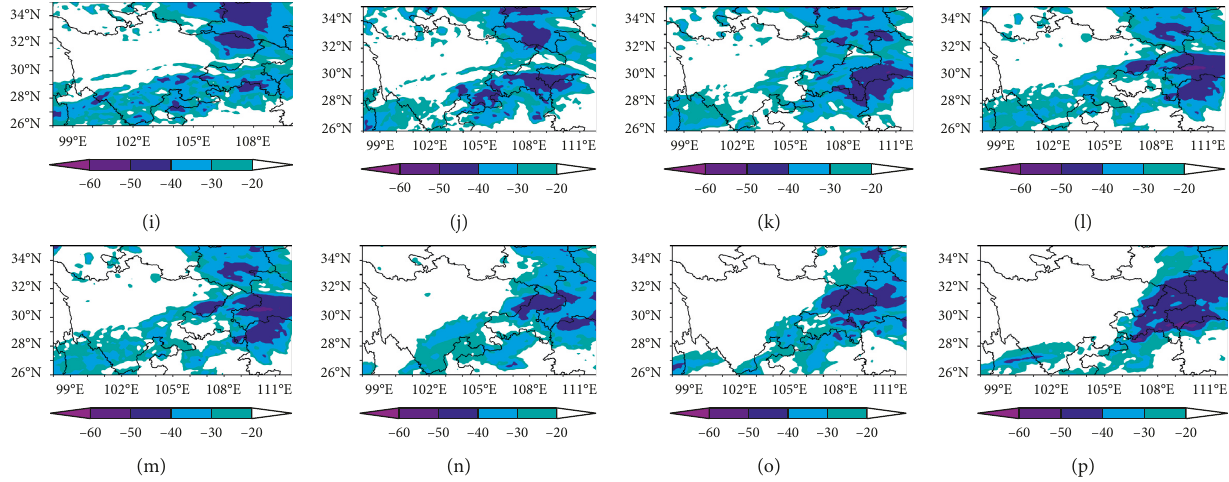
Figure 3: Tb distribution every 2h from 1400 UTC 26 October to 2000 UTC 27 October 2014 (shaded, ° C). (a) 1400 UTC 26, (b) 1600 UTC 26, (c) 1800 UTC 26, (d) 2000 UTC 26, (e) 2200 UTC 26, (f) 0000 UTC 27, (g) 0200 UTC 27, (h) 0400 UTC 27, (i) 0600 UTC 27, (j) 0800 UTC 27, (k) 1000 UTC 27, (l) 1200 UTC 27, (m) 1400 UTC 27, (n) 1600 UTC 27, (o) 1800 UTC 27, (p) 2000 UTC 27.